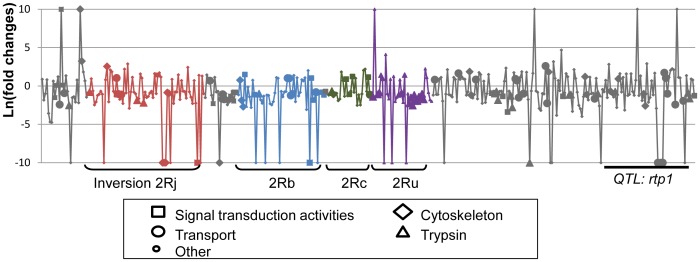
Distribution of differentially accumulated transcripts on chromosome 2R.Fold-changes in transcript accumulation levels between deltamethrin-resistant and susceptible mosquitoes for the significantly differentially accumulated transcripts mapping on chromosome 2R are presented. Various chromosomal inversions (2Rj, 2Rb, 2Rc and 2Ru) are indicated. The position of the QTL rtp1 is also indicated. For representation purposes, transcripts showing read coverage exclusively in susceptible or resistant mosquitoes were attributed an arbitrary fold-change of −10 or 10, respectively.